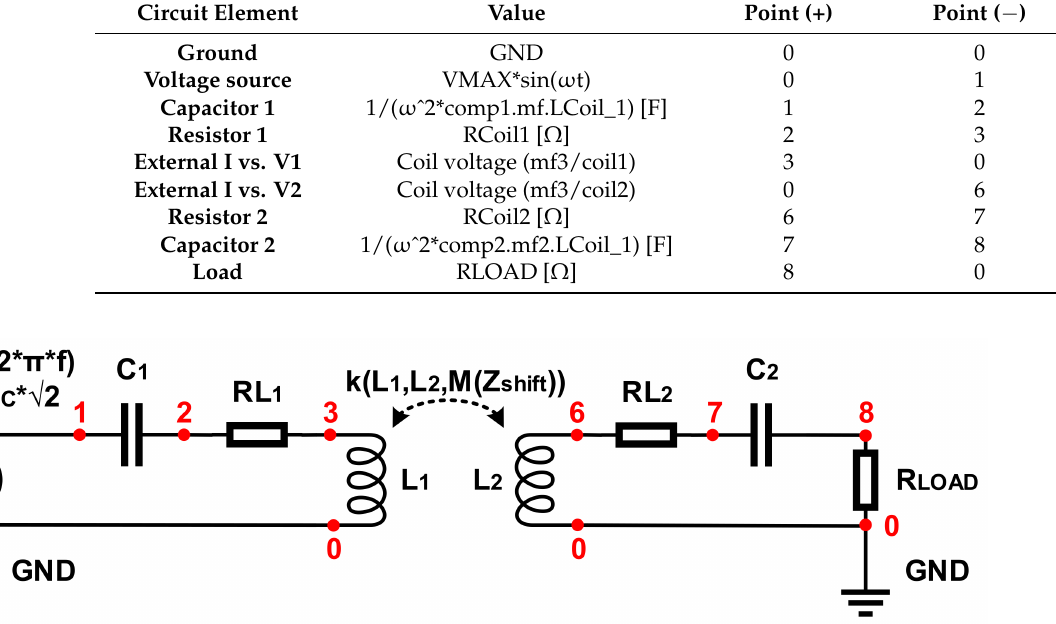
Figure 5. Electrical circuit definition within the electrical domain of the FEM simulation